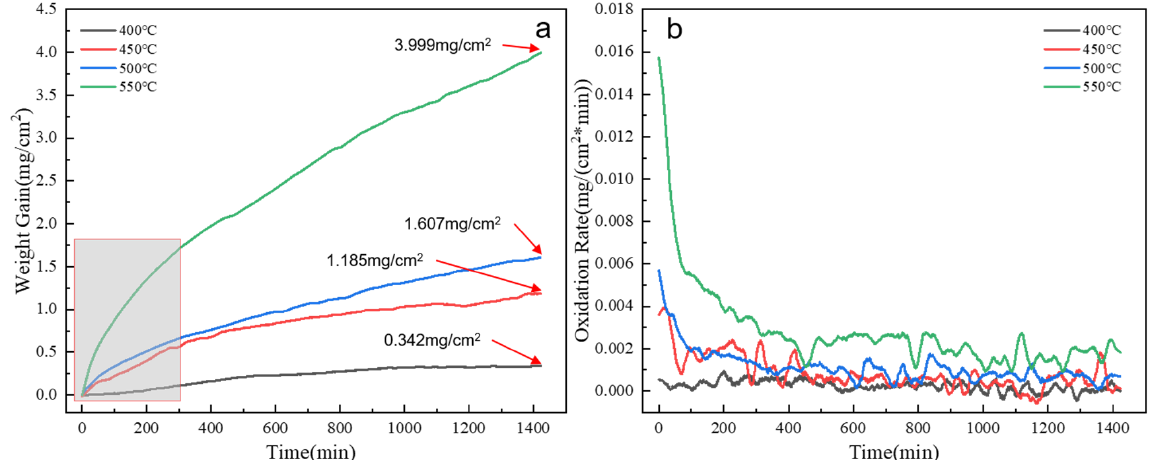
Figure 2. ( a )The weight gain curve of Al–2Li alloy exposed for 24 h; ( b )The weight gain rate curve Figure 2. ( a ) The weight gain curve of Al–2Li alloy exposed for 24 h; ( b ) The weight gain rate curve of Al–2Li alloy exposed for 24 h. of Al–2Li alloy exposed for 24